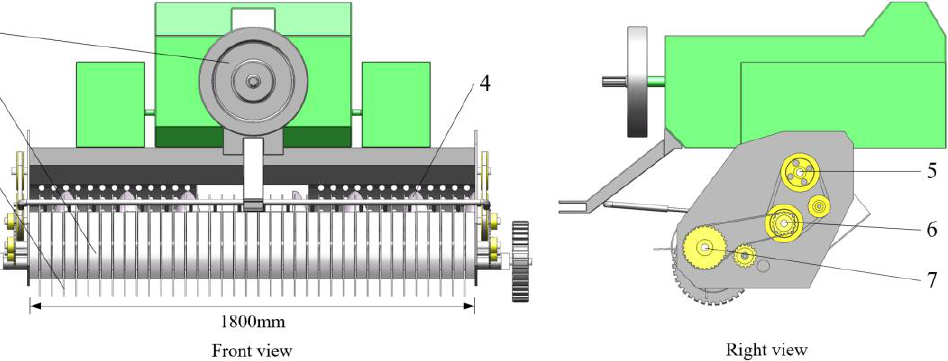
Figure 1. Structure diagram of square baler pickup platform: ( 1 ) flywheel; ( 2 ) pickup elastic teeth; ( 3 ) pickup plate; ( 4 ) screw conveyor; ( 5 ) power input shaft; ( 6 ) screw conveyor shaft; ( 7 ) picker shaft.